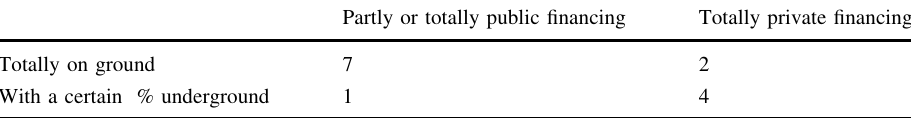
Table 5 Contingency table